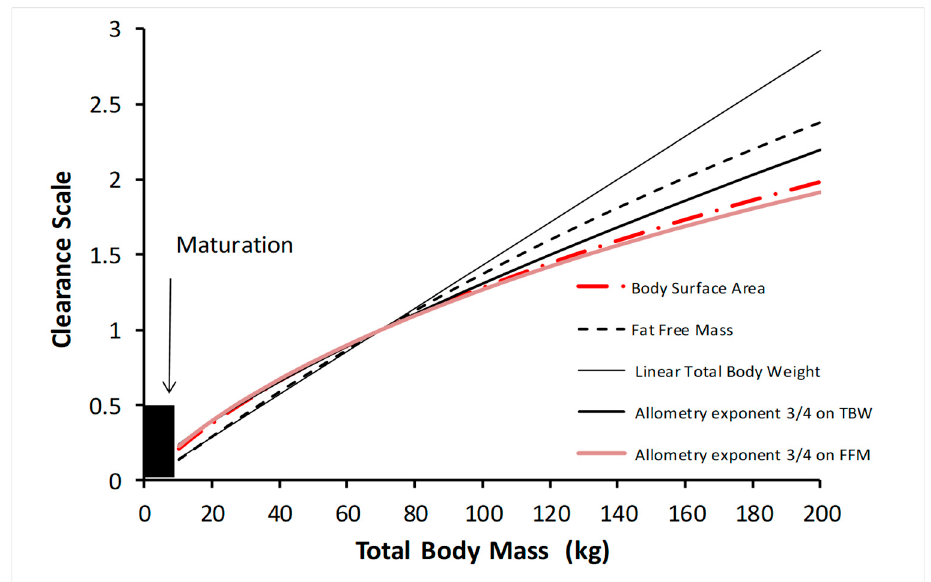
Figure 3. Changes in clearance are demonstrated as total body mass (expressed as weight) increases. The size metrics (body surface area, fat-free mass, linear total body weight, total body weight with allometry, and fat-free mass with allometry) are shown relative to a person with 70 kg total body mass. Children younger than 1 year of age (approx. 10 kg) are not shown because maturation is incomplete in that cohort. There is a nonlinear relationship between weight and clearance for most body size metrics, demonstrated with a curvilinear shape. The per kilogram model is shown as a straight line and increasingly overestimates clearance in adults of weight greater than 70 kg.